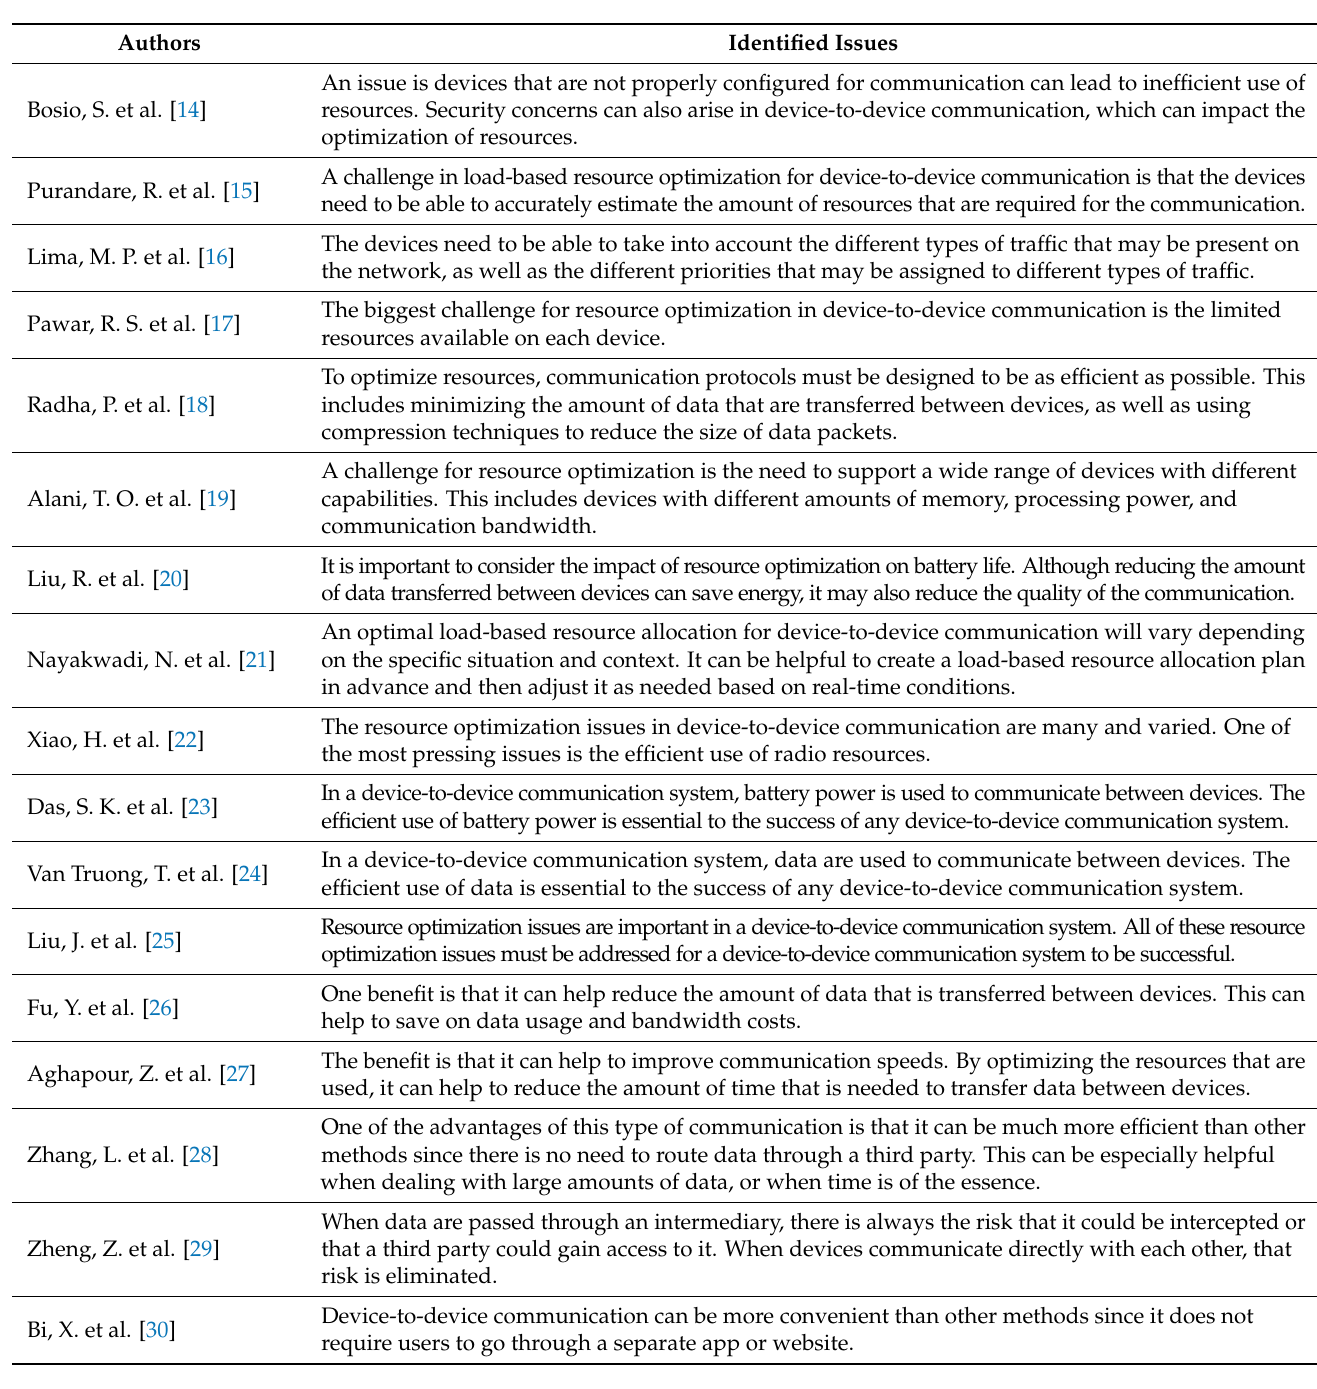
Table 1. Comprehensive